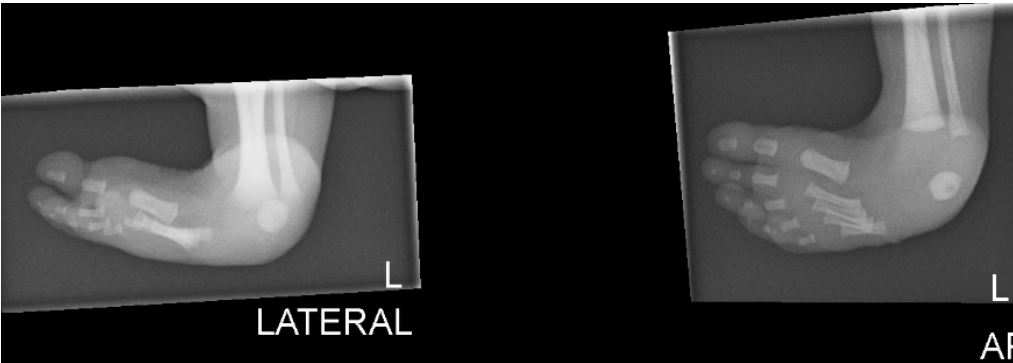
Figure 3. Plain lateral radiograph of foot showing club foot.